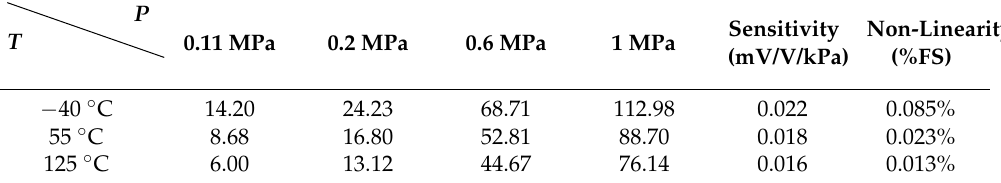
Table 4. Outputs of pressure sensor without a shield layer versus temperature ( T ) and pressure ( P ).